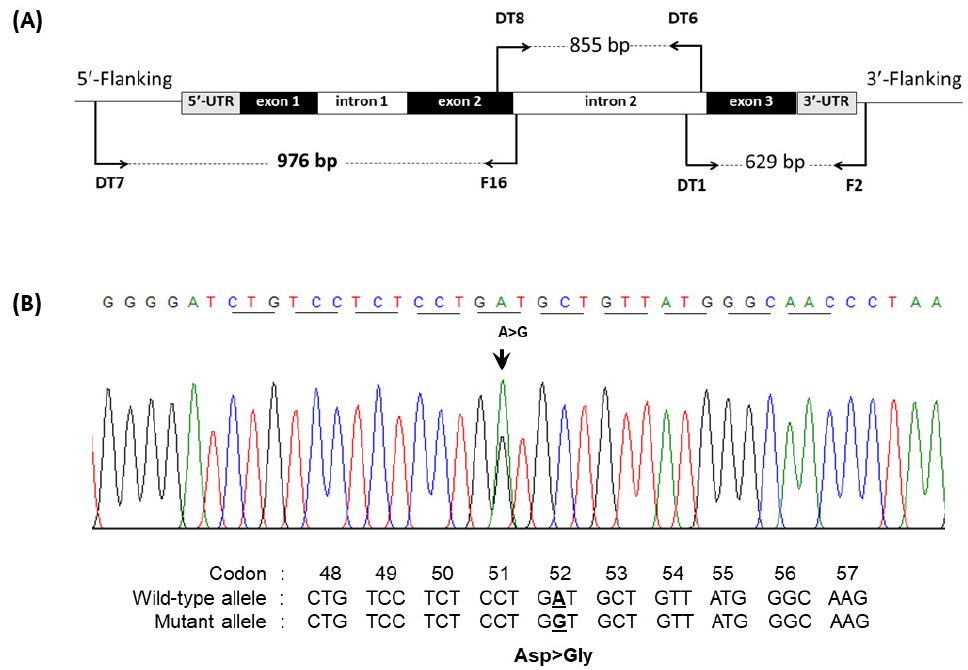
Figure 1. ( A ): Schematic drawing of the whole δ -globin gene, showing the 5 ′ untranslated, encoding and 3 ′ untranslated regions, and the locations and orientations of the specific primers that produced the overlapping fragments of the δ -globin gene. ( B ) Depiction of part of the DNA sequence of the δ -globin gene. The forward sequence demonstrates the substitution of a single nucleotide (A to G) at codon 52 of exon 2 (indicated by an arrow), resulting in a substitution of aspartate for glycine, responsible for Hb A 2 -Mae Phrik.